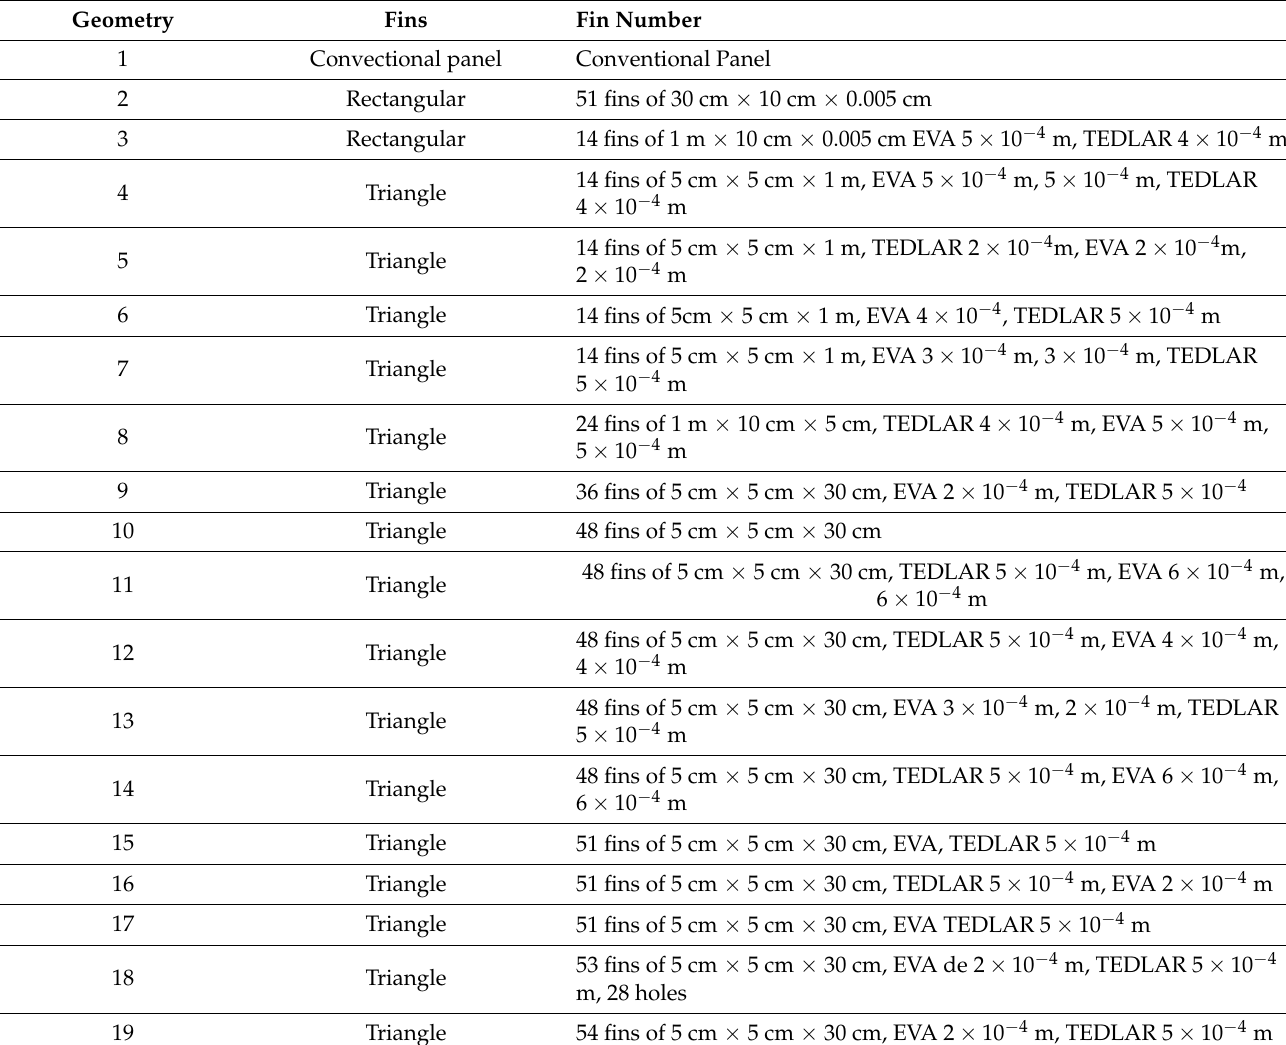
Table 3. Geometries